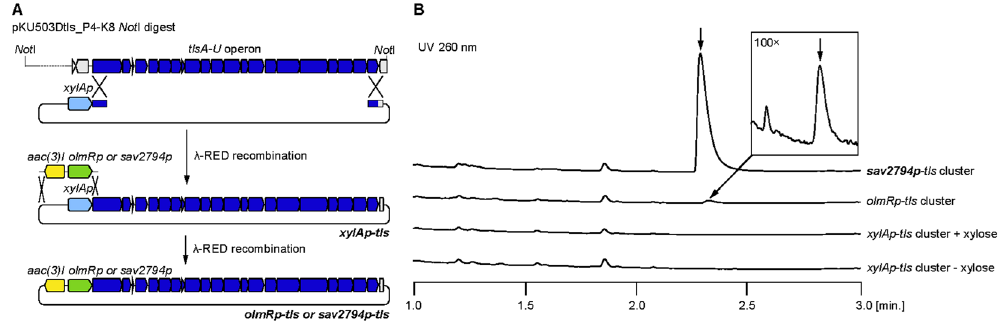
Figure 2. Promoter-assisted heterologous expression of 1 biosynthetic gene cluster in SUKA strain. ( A ) Overview of heterologous expression vector. ( B ) HPLC/MS analysis of metabolites produced by the SUKA17 strain, which was transformed with the tls gene cluster containing the xylA , olmR , and sav2794 gene promoters. The peak from the metabolites from SUKA17 (pKU492Acos:: sav2794p::tls _cluster) showed a m/z ratio of 583 [M + H] + , corresponding to the authentic 1